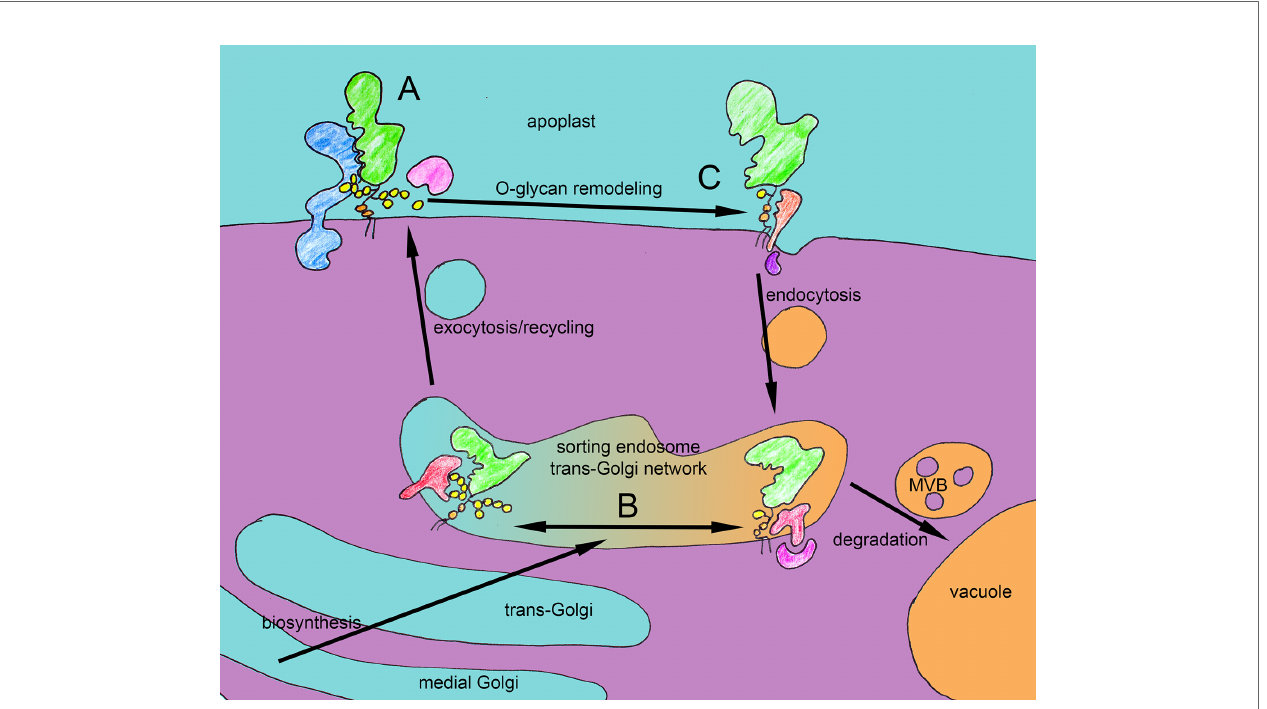
FIGURE 2 | Hypothetical functions of O- glycans of FLA4 in traf fi cking and receptor binding. Three potential scenarios that might explain recent genetic and cell biological observations. (A) The O- glycan (yellow) might be required for interaction between FLA4 (green) and FEI receptor kinases (blue). (B) In the secretory pathway the O- glycan might be checked by a system of different cargo receptors (red) that either bind fully or incompletely O- glycosylated FLA4 and their cytosolic adaptors (purple). While the fully glycosylated FLA4 molecules are rapidly transported to the cell surface via exocytosis, the hypoglycosylated species are targeted for destruction to the vacuoles via multivesicular bodies. (C) Full O- glycosylation might stabilize FLA4 at the cell surface and as binding partner for receptor kinases while its apoplastic remodeling by glycanases (pink) might make the protein competent to be recruited by endocytotic cargo receptors. The number and identity of the involved molecular components are unknown and despite their colorful depiction, the symbols for receptors and cytosolic adaptors represent “ black boxes ” at the